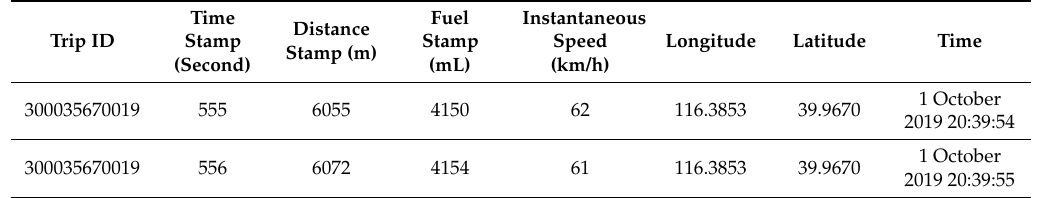
Figure 1. The Y-BOX300. Table 1. The sample of the trajectory data.